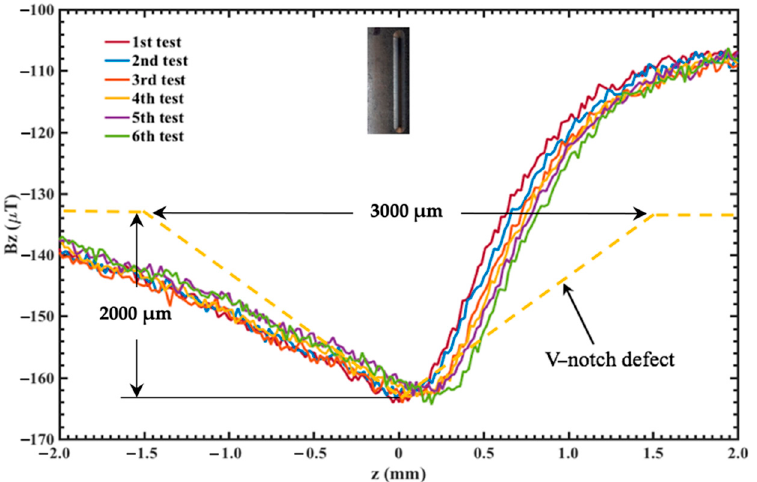
Figure 9. Variation of tangential MMM signals measured around the fourth V-shaped notch (3000 µm width and 2000 µm depth) of the ASTM-A36 steel pipe, which were measured using six experimental tests.